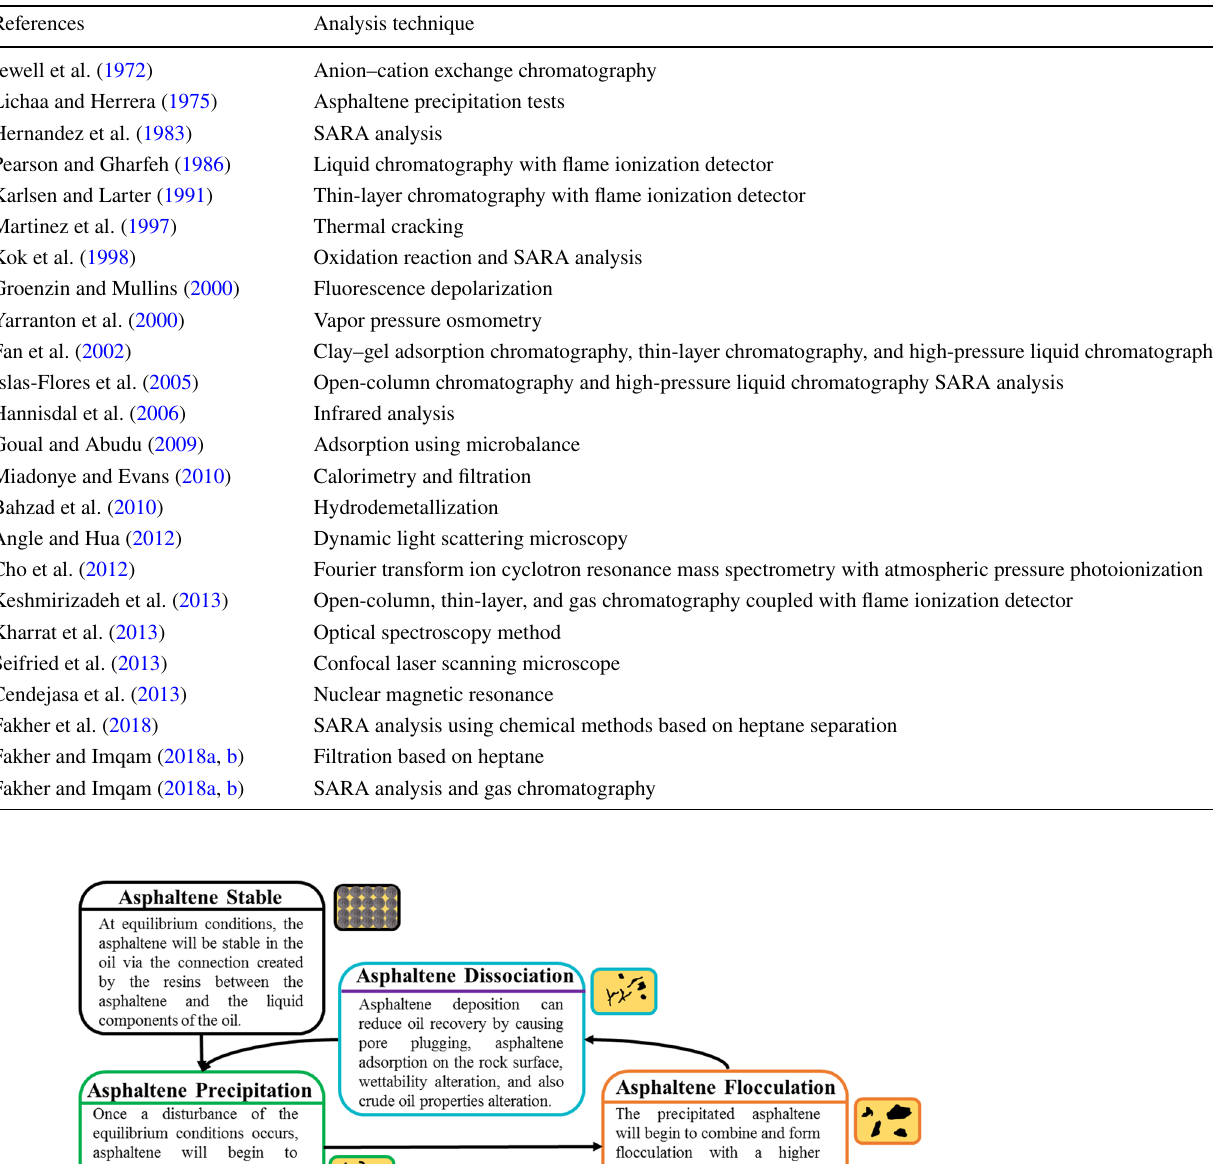
Table 1 Summary of chemical analysis methods of asphaltene over the